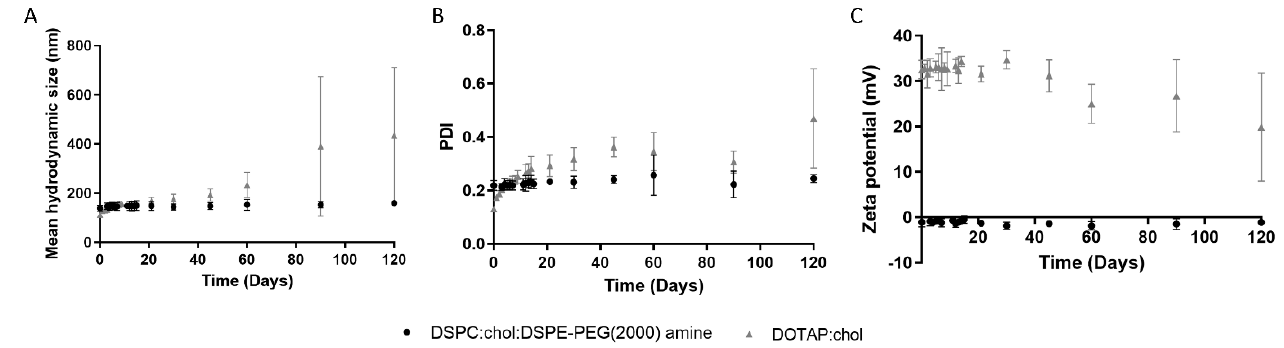
Figure 1. Physicochemical characterization of liposomes over 4 months in terms of ( A ) hydrodynamic diameter, ( B ) PDI, and ( C ) zeta potential values.